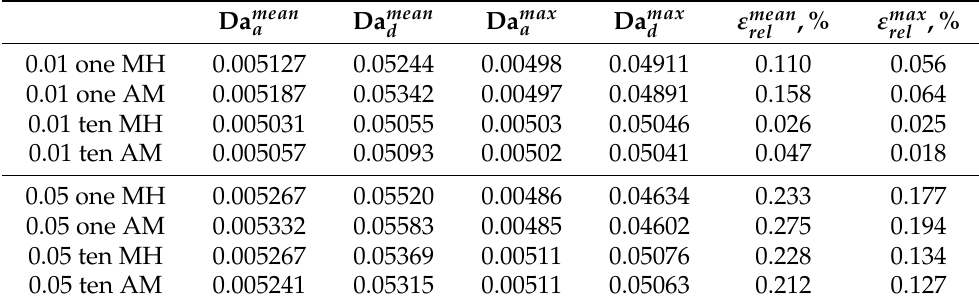
Figure 7. 95% credibility interval for: ( a ) one observation data for different noise variances, ( b ) ten observation data for different noise variances, ( c ) comparison with noise σ 2 = 0.01, ( d ) comparison with noise σ 2 = 0.05. Table 1. True values: Da a = 0.005, Da d =